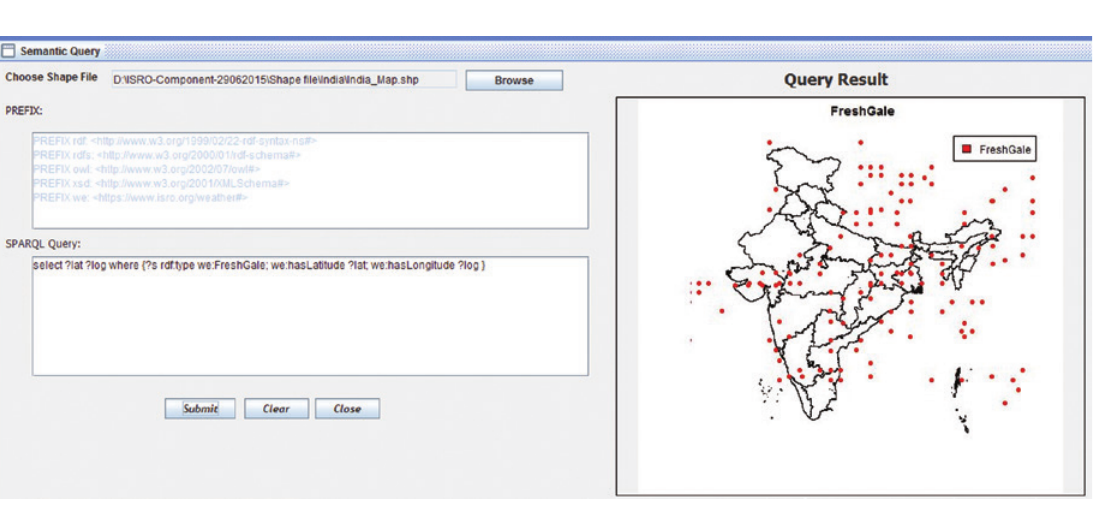
Figure 16: SPARQL Query